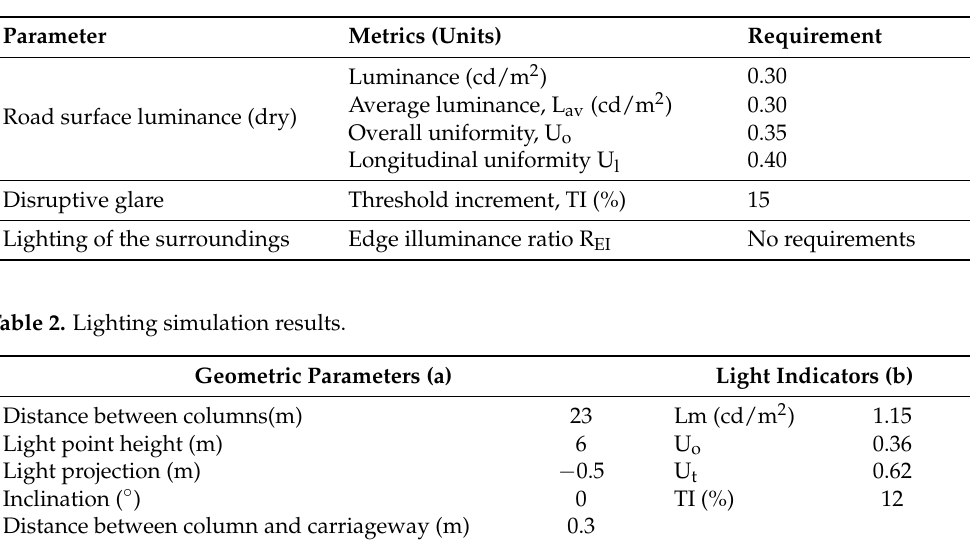
Table 1. Minimum values of lighting parameters for the road type (M6).